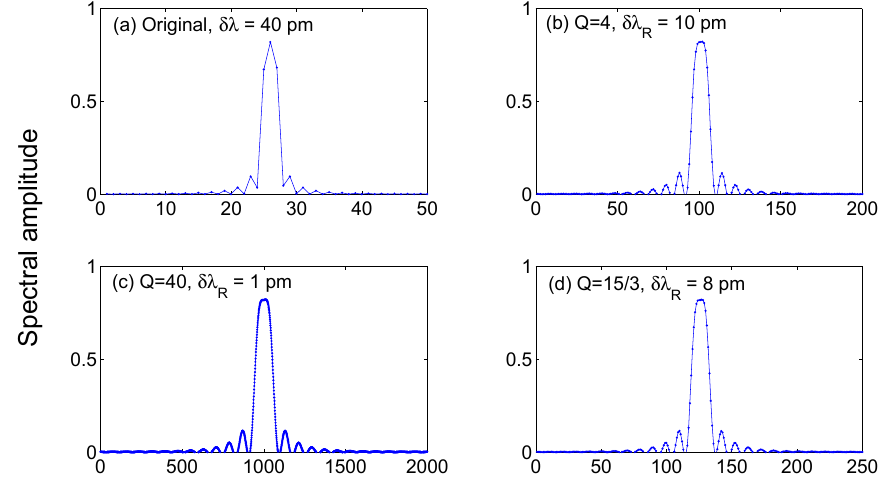
Figure 12. Effect of resampling on a FBG spectrum: the figure shows an FBG spectrum simulated on a wavelength grid of 40 pm resolution filtered through a polyphase resampling filter, showing the digital signals input ( a ) and output ( b – d ) of the resampler. ( a ) Original signal; ( b ) polyphase filter with Q = 4, bringing the artificial resolution to 10 pm; ( c ) polyphase filter with Q = 40, bringing the artificial resolution to 1 pm; ( d ) polyphase filter with Q = 15/3, bringing the artificial resolution to 8 pm.